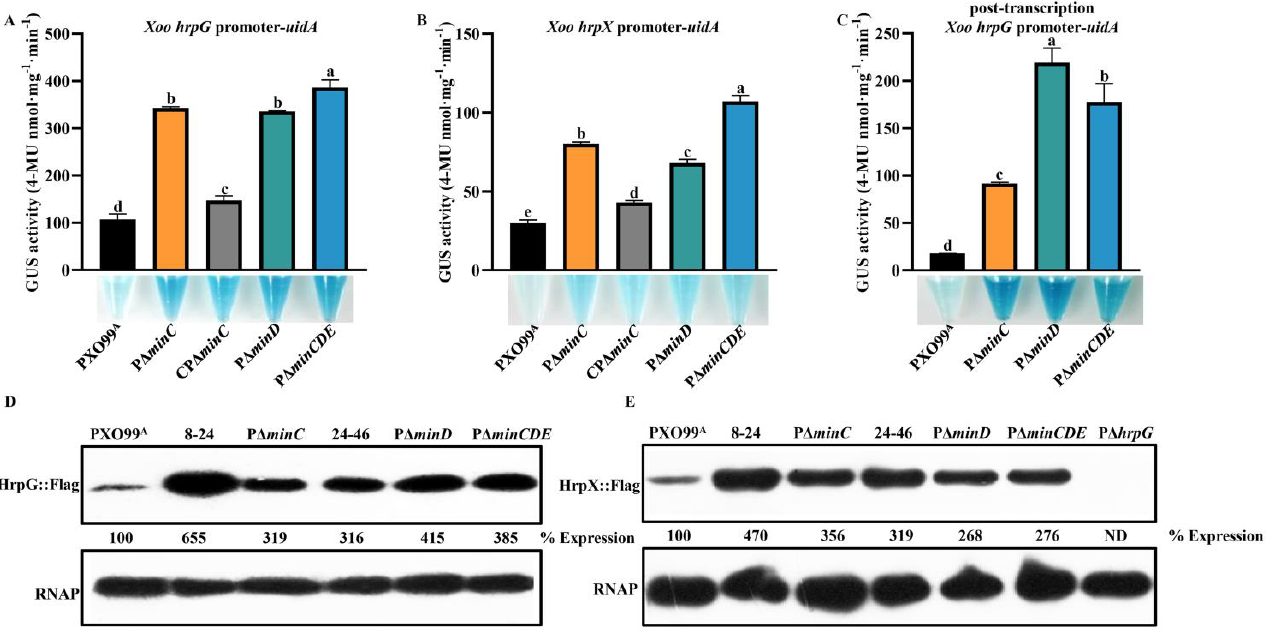
Figure 2. The Min system negatively regulates the expression of hrpG and hrpX . ( A ) The hrpG promoter-driven GUS activity of Xoo wild-type PXO99 A , P∆ minC , CP∆ minC , P∆ minD , and P∆ minCDE in XOM3 at 3 hr post-induction. ( B ) The hrpX promoter-driven GUS activity of PXO99 A , P∆ minC , CP∆ minC , P∆ minD , and P∆ minCDE in XOM3 at 3 hr post-induction. ( C ) The hrpG expression-driven GUS activity of PXO99 A , P∆ minC , P∆ minD , and P∆ minCDE harboring a post-transcription hrpG :: uidA fusions in XOM3 at 12 hr post-induction. ( D ) The abundance of HrpG proteins in PXO99 A , 8 –24, P∆ minC , 24 – 46, P∆ minD , and P∆ minCDE by Western blotting. The data revealed that mutation of Min system increased the HrpG protein levels by more than 3.16-fold. ( E ) The abundance of HrpX proteins in PXO99 A , 8 –24, P∆ minC , 24 – 46, P∆ minD , and P∆ minCDE by Western blotting. P∆ hrpG as a negative control of HrpX protein expression. The data revealed that mutation of Min system increased the HrpX protein levels by more than 2.68-fold. The total protein extracts were analyzed by Western blotting using anti-FLAG antibodies. RNAP, RNA polymerase subunit alpha from E . coli was used as a loading control. Relative protein abundance was calculated by ImageJ software. Similar results were observed in two independent experiments. As assessed by Duncan ’ s test, different letters indicate statistically significant differences, and the same letter displays no significant differences ( p < 0.05) between Xoo strains.